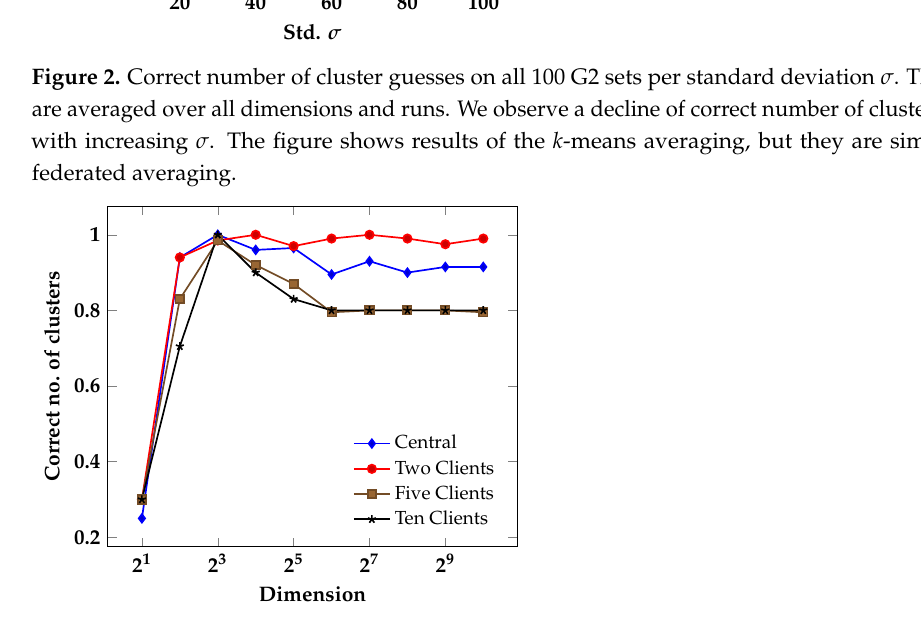
Figure 3. Correct number of cluster guesses on all 100 G2 sets per dimension. The values are averaged over all values of σ and runs. We observe few correct guesses in the two dimensional case, a peak for D = 8, then a decline that stabilizes after D = 64. The overall trend is similar for all number of clients. The figure shows results of the k -means averaging, but they are similar with federated